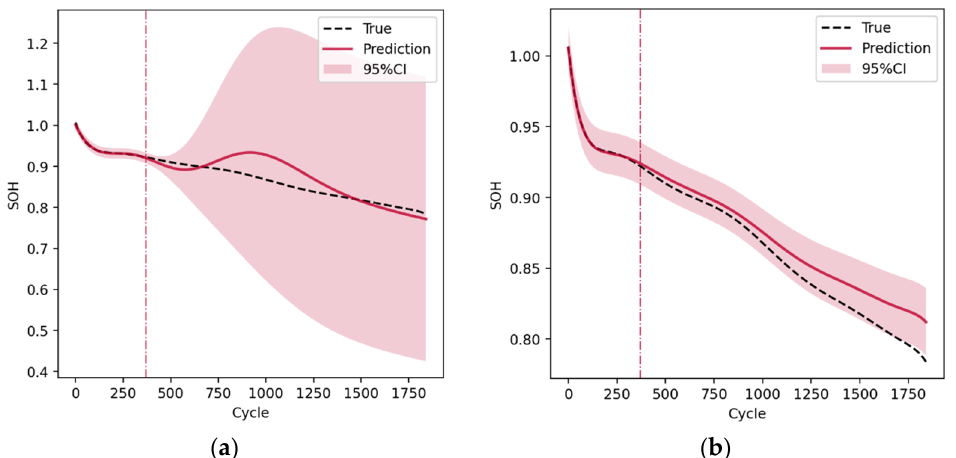
Figure 6. SOH prediction of the battery pack based on the MOGPR with different HIs: ( a ) only using the cycle number as the HI; ( b ) using the cycle number and stdQ as the HIs.